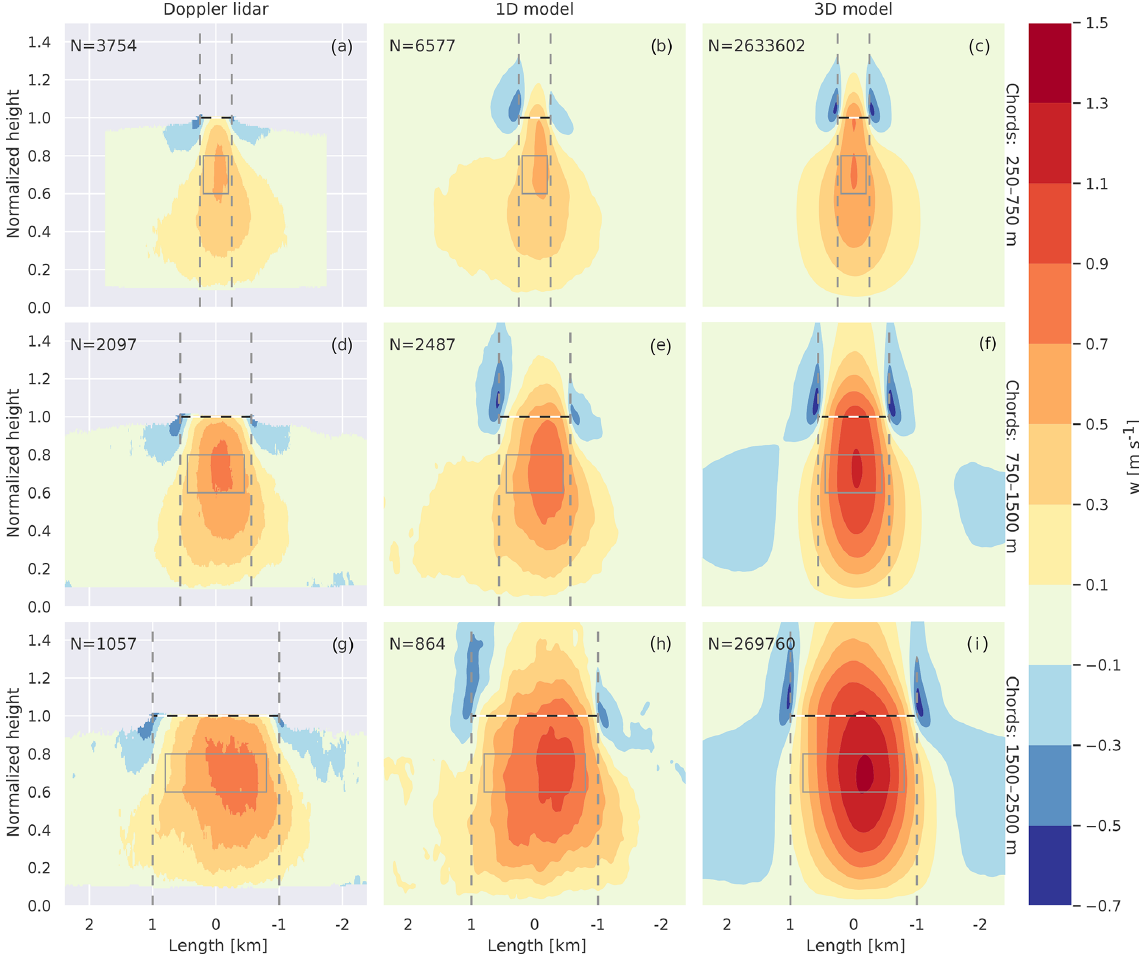
Figure 9. Normalized vertical velocity scenes from Doppler lidar observations (a, d, g) , 1D column output (b, e, h) , and 3D snapshots (c, f, i) . The scenes are composites of the normalized scenes binned by chord lengths of 250–750m (a, b, c) , 750–1500m (d, e, f) , and 1500– 2500m (g, h, i) . After merging the scenes the normalized length is rescaled to match the mean length of the bin (e.g., 500m for 250–750m). The black dashed and white horizontal line marks the chord base, the dashed grey lines the chord beginning and end, and the grey box the area averaged for Fig. 8. See Sect. 2.1 for information on the Doppler data and Sect. 3.2–3.1 for descriptions of how chords were derived from the MicroHH simulations. Doppler lidar scenes are only shown when at least 70% of the scenes contain